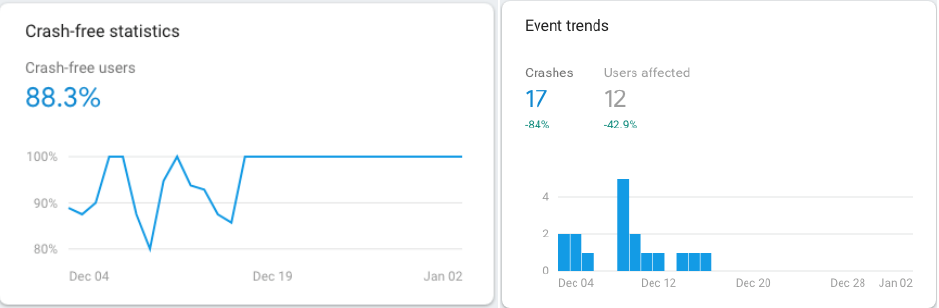
Figure 15. TeenPower mobile app — crash-free statistics (30-day period starting on 4 December 2018).